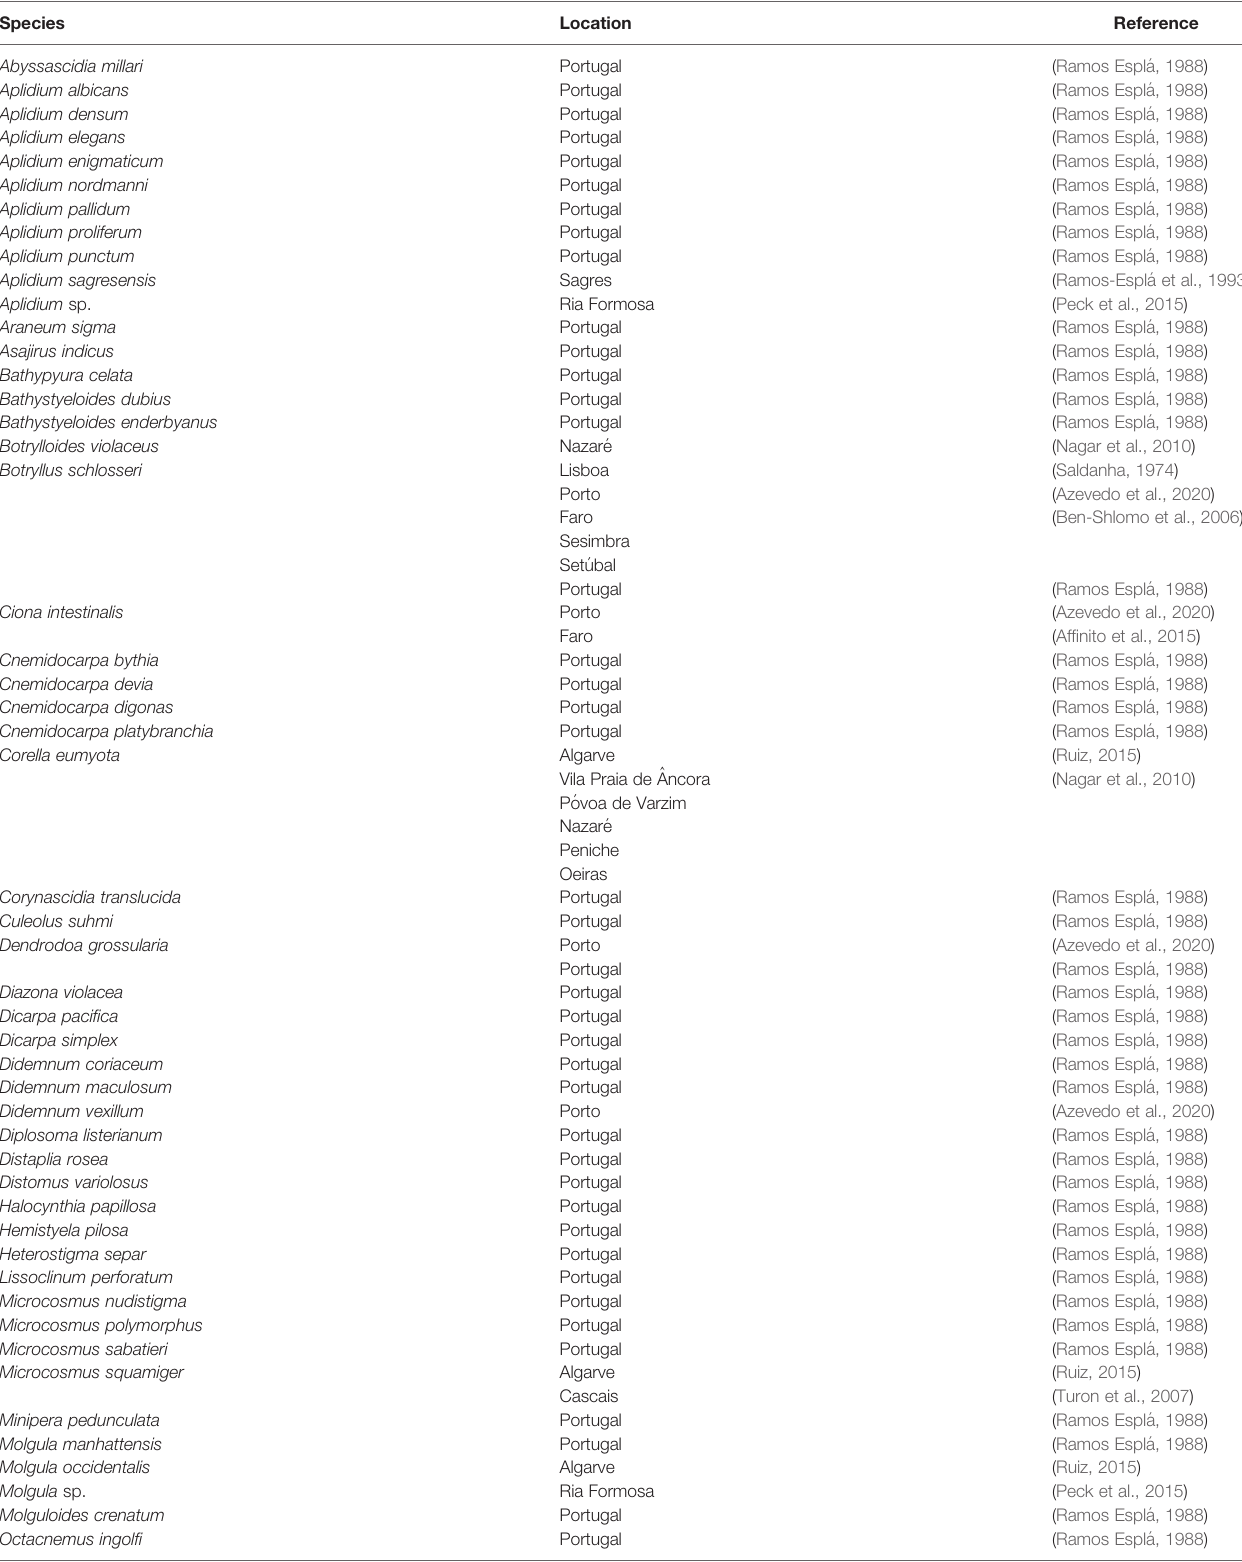
TABLE 4 | List of recorded ascidian species from the coastal waters of mainland